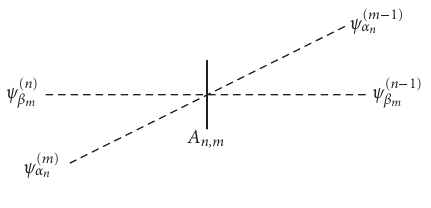
Figure 2.4. Notations for ( n , m )th vertex of the auxiliary